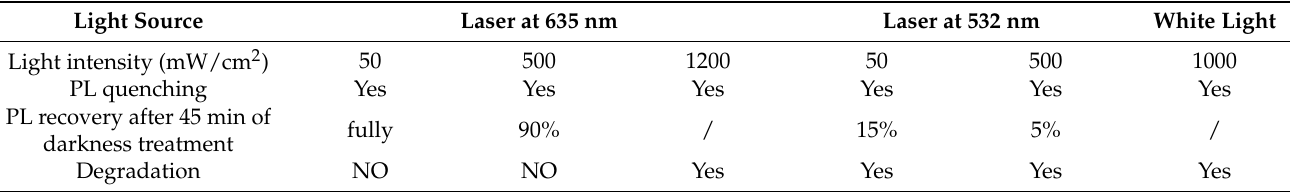
Table 1. All experimental results of the quasi-2D perovskite films under ambient conditions. Light Source Laser at 635 nm Laser at 532 nm White Light Light intensity (mW/cm 2 ) 50 500 1200 50 500 1000 PL quenching Yes Yes Yes Yes Yes Yes PL recovery after 45 min of fully 90% / 15% 5% / darkness treatment